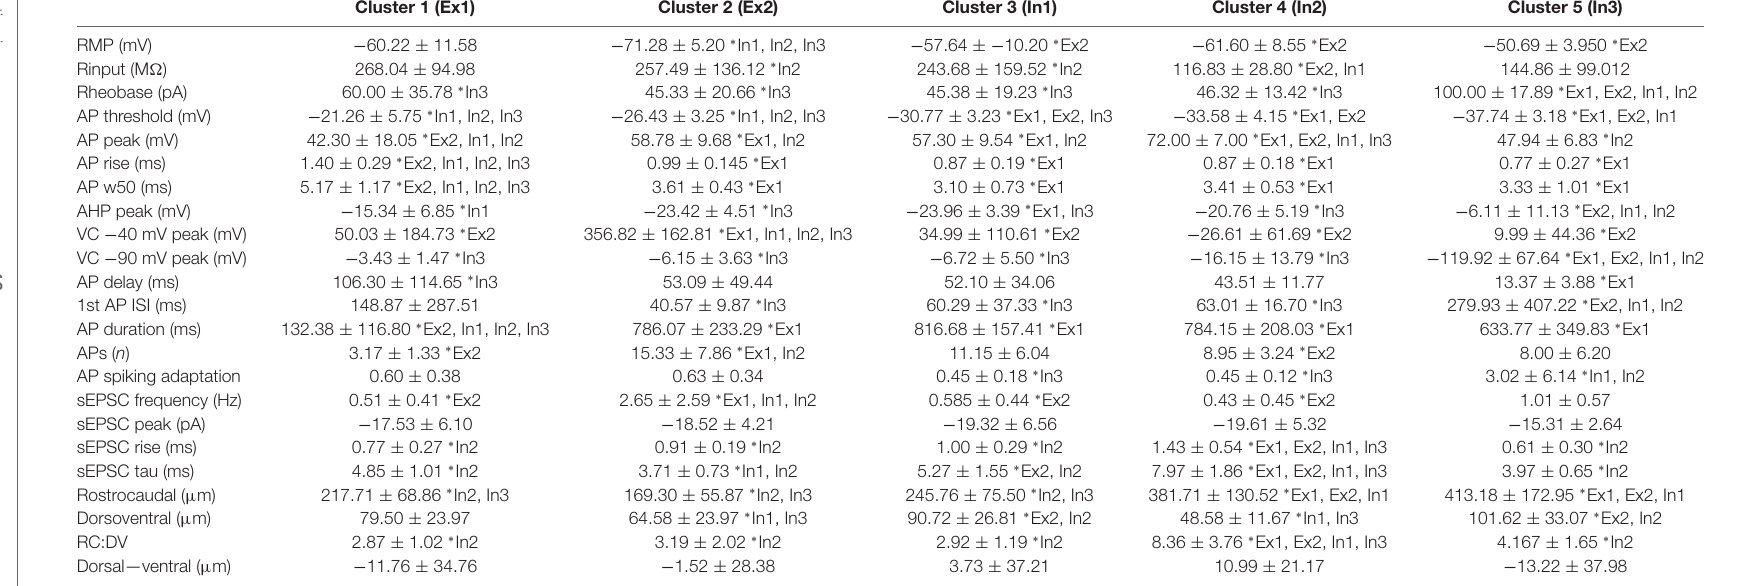
TABLE 5 | Cluster specific